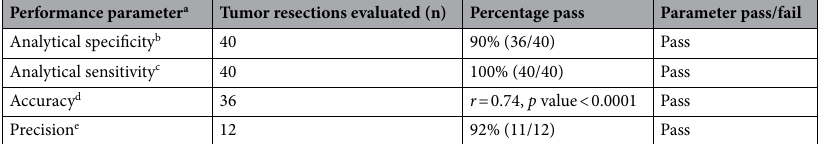
Table 2. DKK1 RNAscope digital image analysis validation results. a Details of the pre-defined acceptance criteria are described in the methods. b Algorithm accurately identified cells as objects, accurately classified tumor and stromal compartments of the tissue, and accurately classified DKK1 negative cells. c Algorithm accurately identified cells when present and classified DKK1 positive cells correctly. d Pearson correlation ( p value < 0.05) with DKK1 manual H-scores. e Results across 3 separate staining days within the same binned category of expression (negative bin: H-score = 0, low bin: H-score < 34, and high bin: H-score ≥ 35). In cases of discordant binning of negative, low or high categories, a ± 20 point H-score discrepancy was still considered